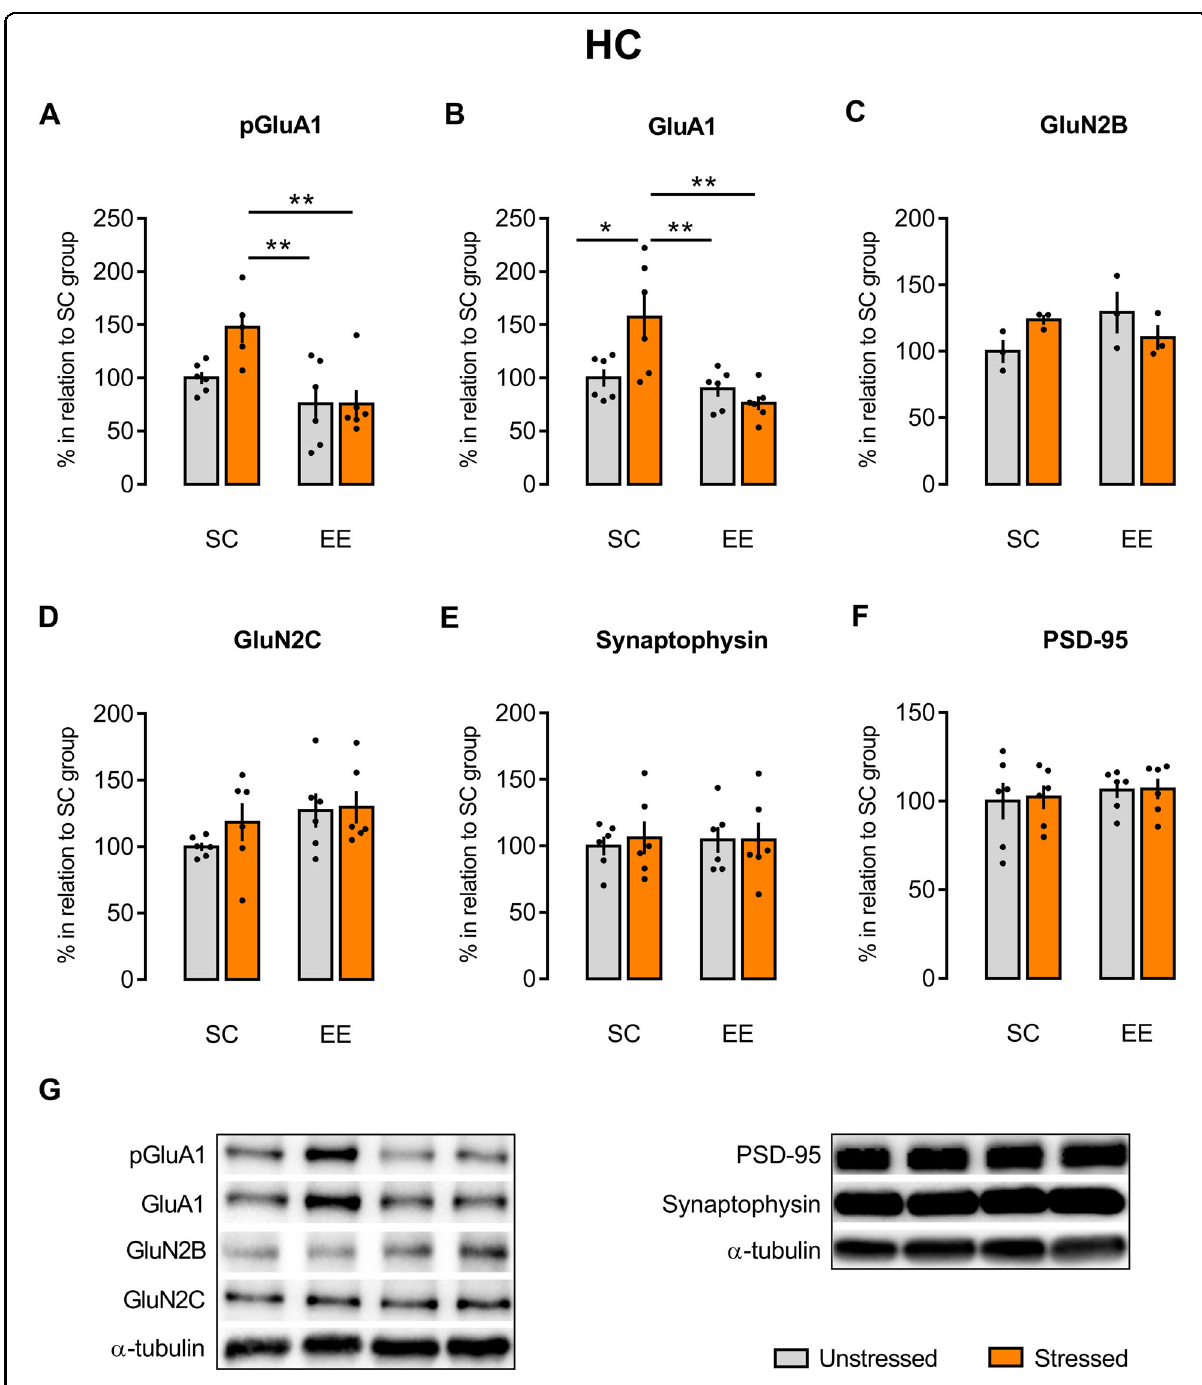
Fig. 3 EE prevents the stress-induced increase in pGluA1/GluA1 expression in the HC. Stressed SC-housed animals showed higher expression of pGluA1 ( A ) and GluA1 ( B ) in the HC comparing to SC-housed, unstressed (only in B ), EE-housed, stressed and unstressed animals. EE-housed animals (both stressed and unstressed) presented the same expression levels of pGluA1 ( A ) and GluA1 ( B ) than SC-housed, unstressed animals. There were no differences in the GluN2B ( C ) and GluN2C ( D ) expression in both SC- and EE-housed animals (stressed or unstressed). There were no differences in the synaptophysin ( E ) and PSD-95 ( F ) expression in both SC- and EE-housed animals, regardless of the presence of stress. Representative autoradiography of western blot ( G ). Results are represented as mean ± SEM ( n = 5 – 6 animals per group in A ; n = 6 for each group in B , D – F ; n = 3 for each group in C ). Two-way ANOVA followed by Tukey ’ s multiple comparisons test. Signi fi cance differences between groups are indicated as * p < 0.05 and ** p <